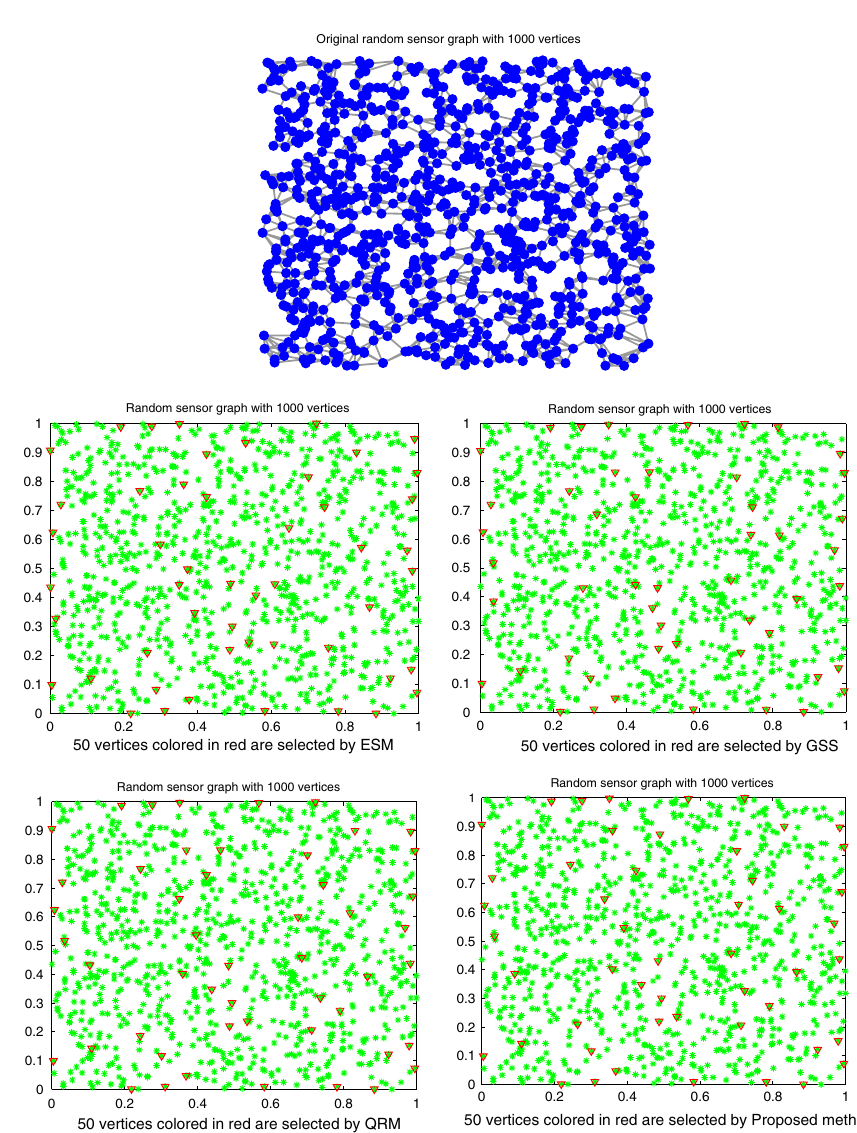
Fig. 1 Fifty vertices in red selected from RSG by using four different sampling